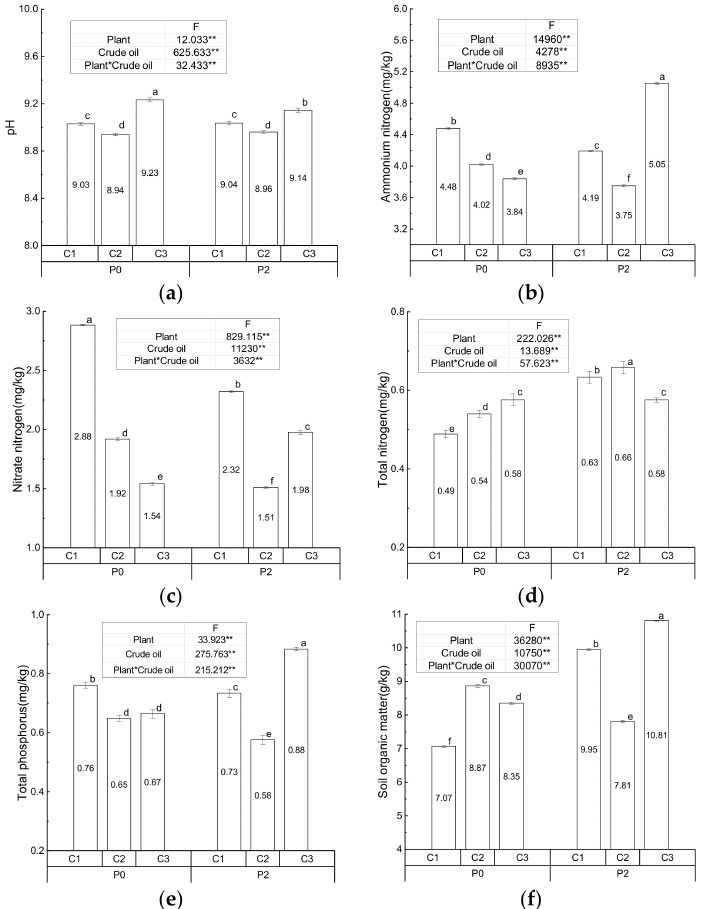
Figure 1. Soil physiochemical composition, including pH ( a ), Ammonium nitrogen ( b ), nitrate nitrogen ( c ), Total nitrogen ( d ), Total phosphorus ( e ), Soil organic matter ( f ) in all controls and treatments. (** indicates the significant di ff erence at the 0.01 level, and average values are in the center of column (calculated from three replicates), meanwhile the error bar of the column is the value of standard deviation. Columns noted by the same and di ff erent small letter means insignificant and significant di ff erence at the 0.05 level,